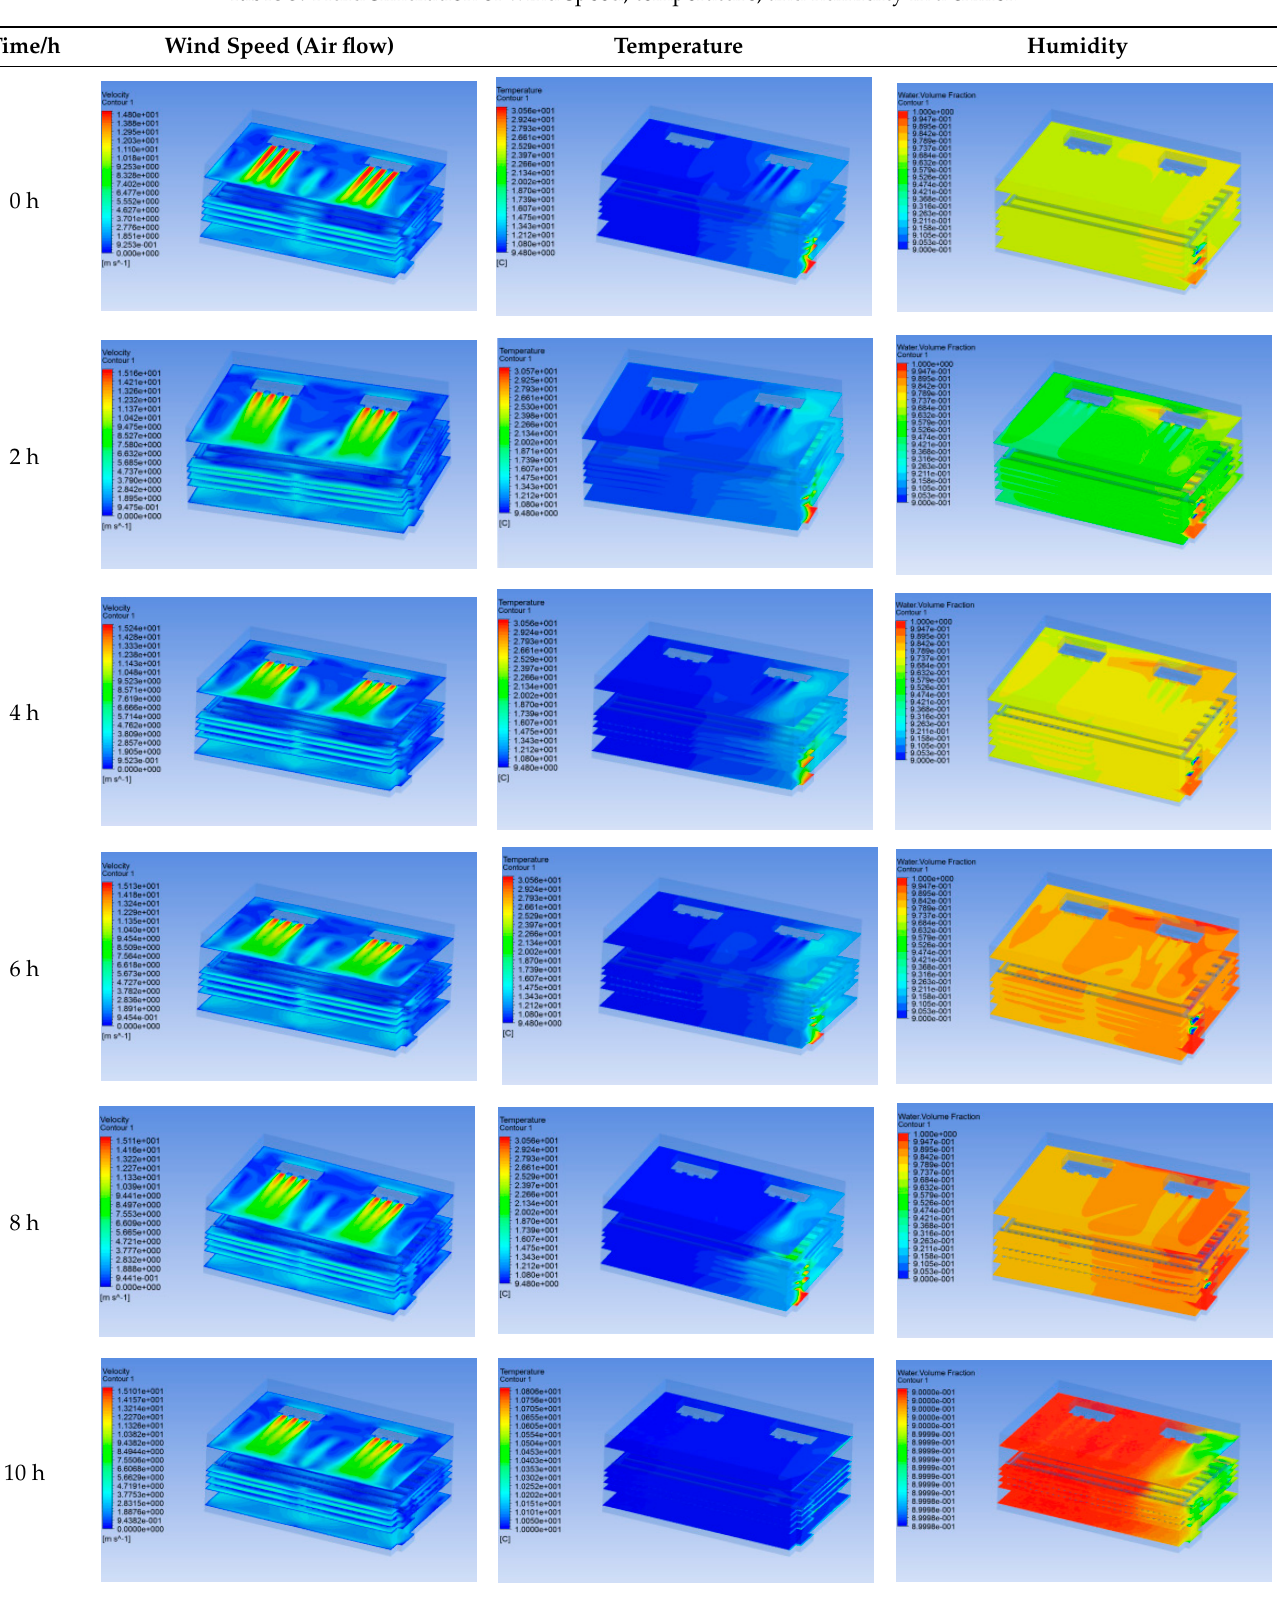
14 h In the wind speed diagrams, different colors represent different wind speeds. The more biased the red color is, the high- er the wind speed, and the more biased the blue, the lower the wind speed. Different colors represent different temper- atures, and the more biased the red color iss, the higher the temperature, and the more biased the blue, the lower the temperature. The more biased the red, the higher the humidity, and the more biased the blue, the lower the humidity. Although the wind speed distribution was slightly different during chilling, no sig- nificant changes were observed, indicating that the arrangement of pig carcasses did not affect the distribution of airflow in the chiller. The wind speed was higher in the places where the fan was located or close to the ground. This was because the high-speed air flow blown by the fan was on the top layer, and the cold air was not spread upwards but downwards. When the overall wind speed in the chiller was high, the air exchange on the chiller door was not obvious. The airflow of the chiller had good symmetry in the horizontal direction. Thus, the layout of the chiller and the arrangement of pig carcasses are reasonable.